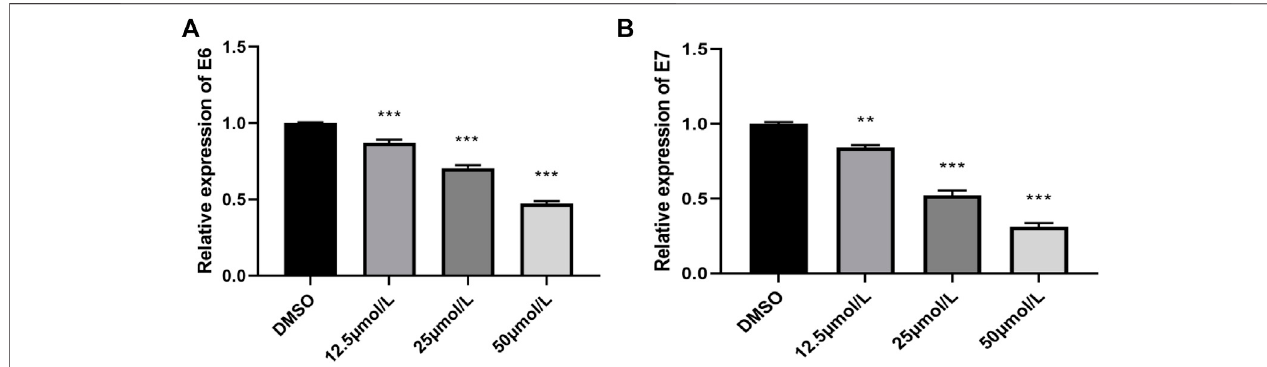
FIGURE 3 | Effect of RPDPD on the expressions of E6 mRNA and E7 mRNA. (A) Relative expression levels in E6 mRNA cells. (B) Relative expression levels in E7 mRNA cells. * p < 0.05 and ** p < 0.01 (x ± s, n = 3).